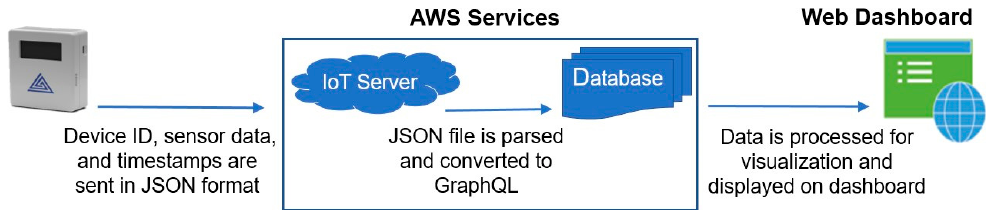
Figure 3. The AeroSpec sensor network system diagram. The hardware unit transmits the data to the AWS database as JSON format, and the analyzed data are displayed in 3D visualization format on the web-based software in real-time using the AWS database.